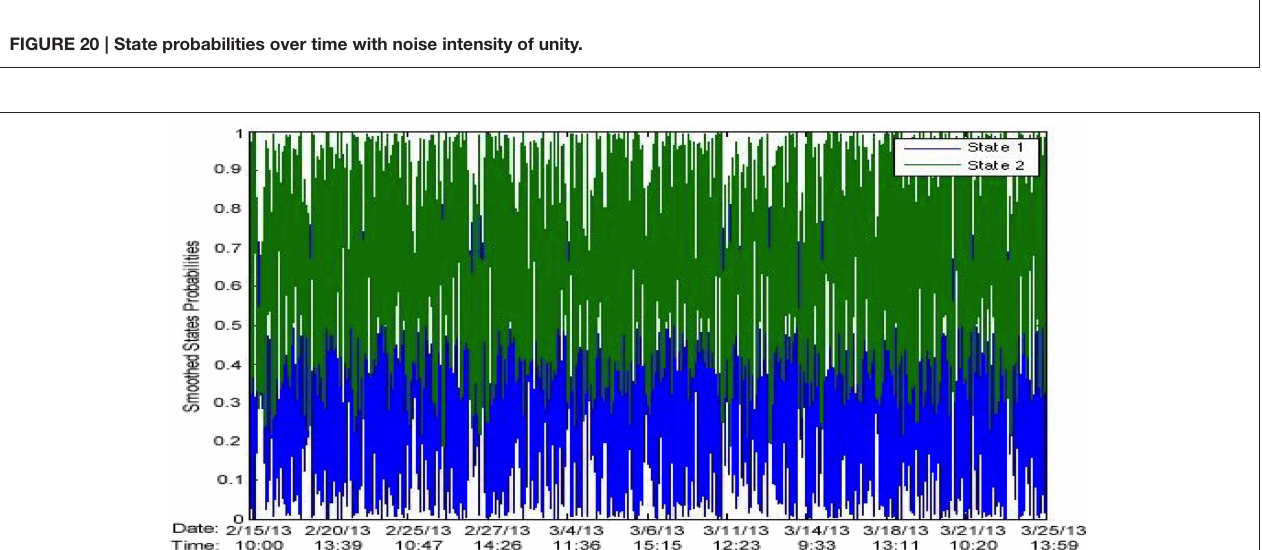
FIGURE 21 | HMM on log returns of noise-corrupted signal in Figure 8B. State probabilities over time.